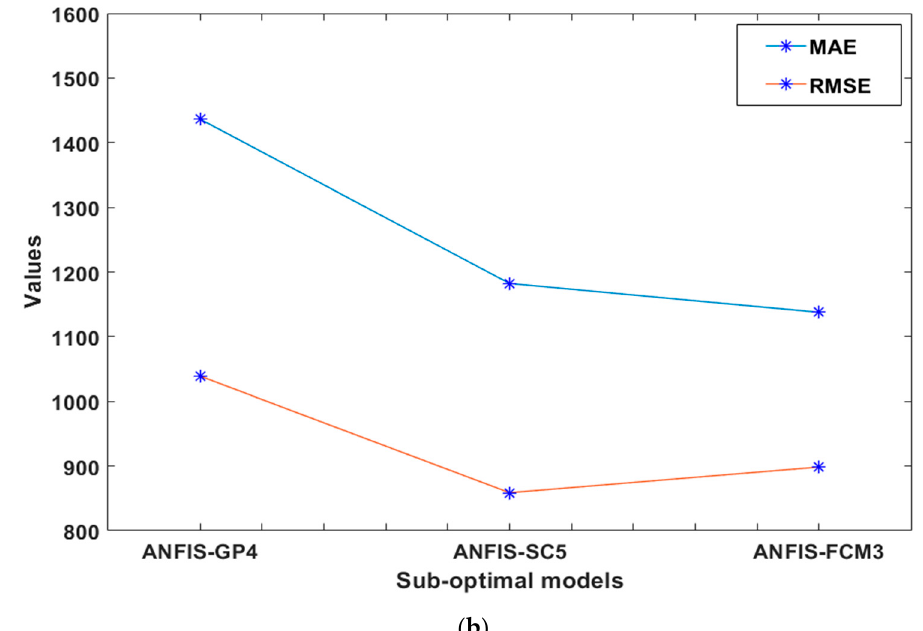
Figure 5. Graph of statistical metrics for ( a ) MAPE, RCoV, CVRMSE, and CT ( b ) MAE and RMSE.